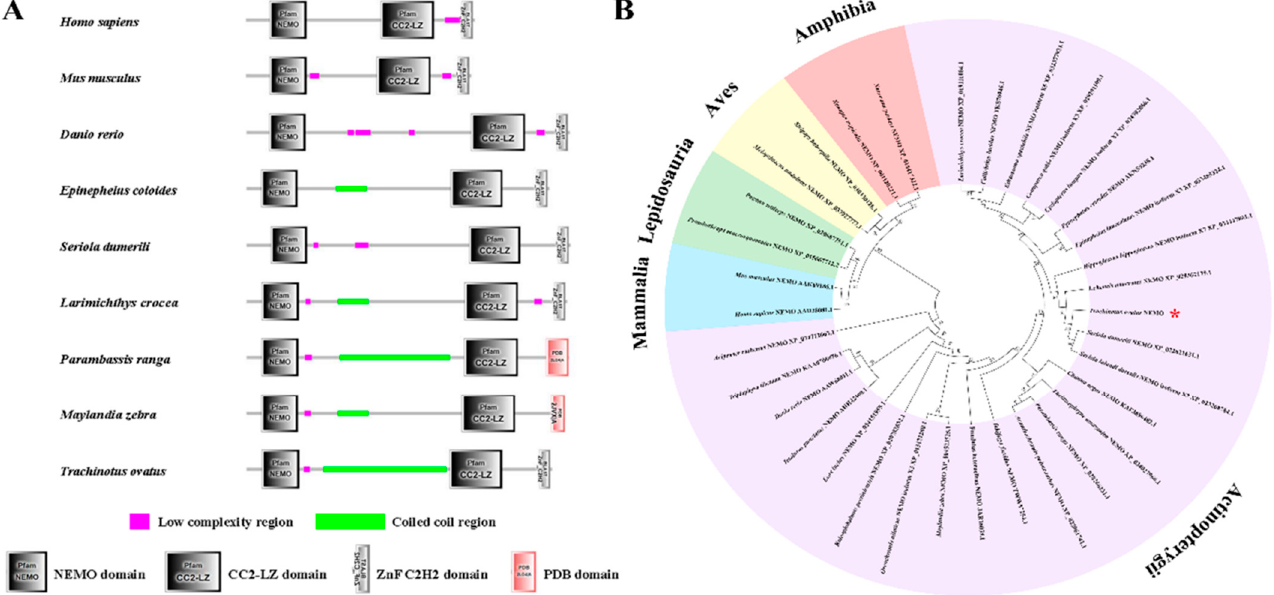
Figure 5. Protein structure ( A ) and phylogenetic tree ( B ) of comparing ToNEMO with other NEMO vertebrates. SMART was used to predict and aligned NEMO protein structure of T. ovatus and other species. MEGA 7.0 with neighbour-joining (NJ) method was used to structure phylogenetic tree. T. ovatus is marked by green shading ( A ) and red asterisk ( B ). The accession numbers are listed in Table S1.